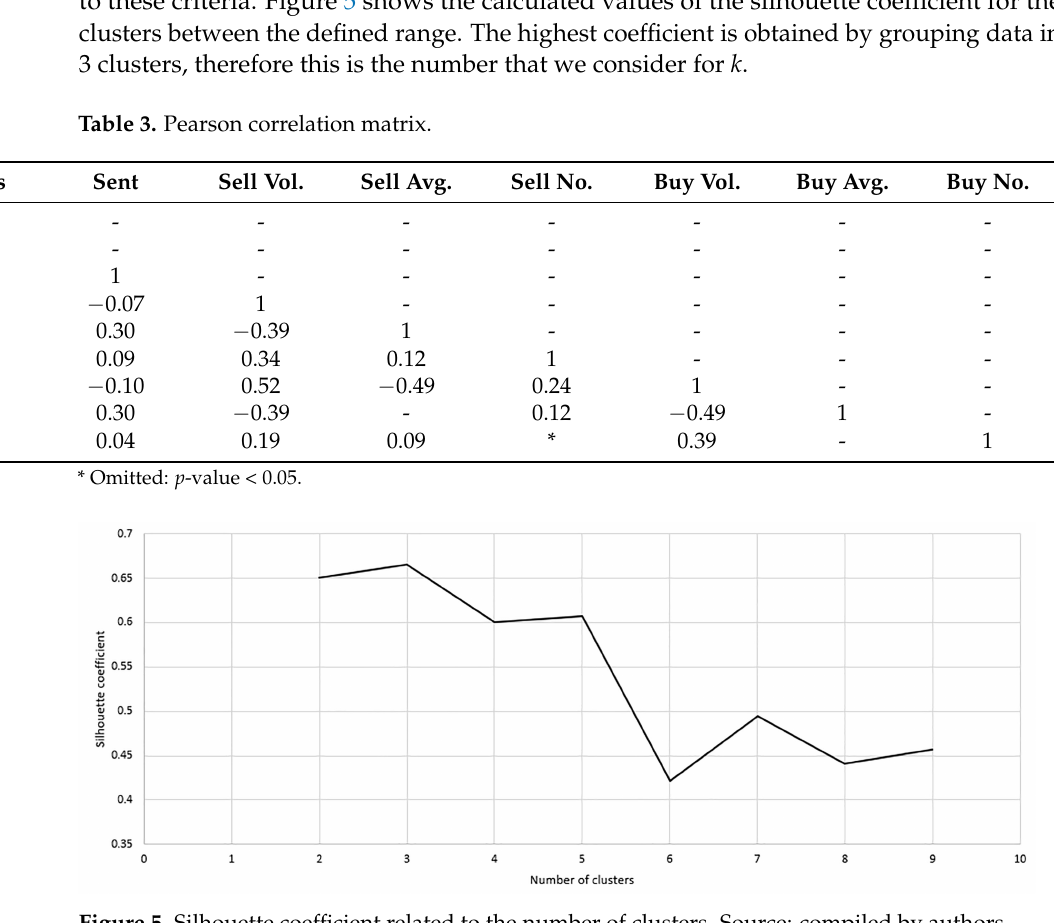
Figure 5. Silhouette coefficient related to the number of clusters. Source: compiled by